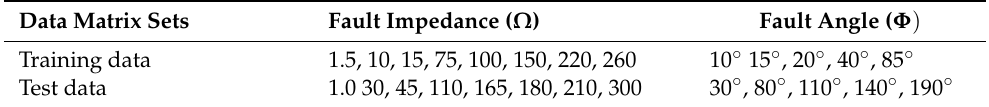
Table 4. Training and testing data.